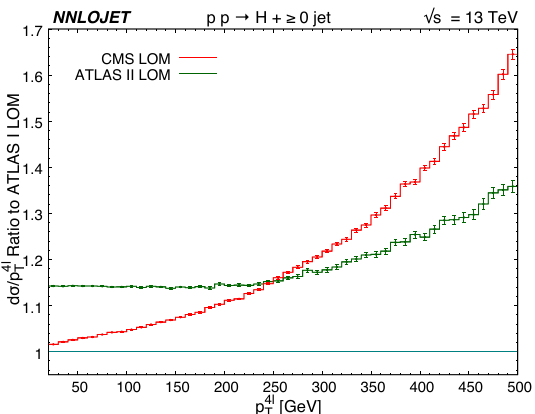
Figure 2. Leading order (with full quark mass effects) four-lepton p using different fiducial cuts and normalised with respect to the ATLAS I [30] fiducial cuts listed in